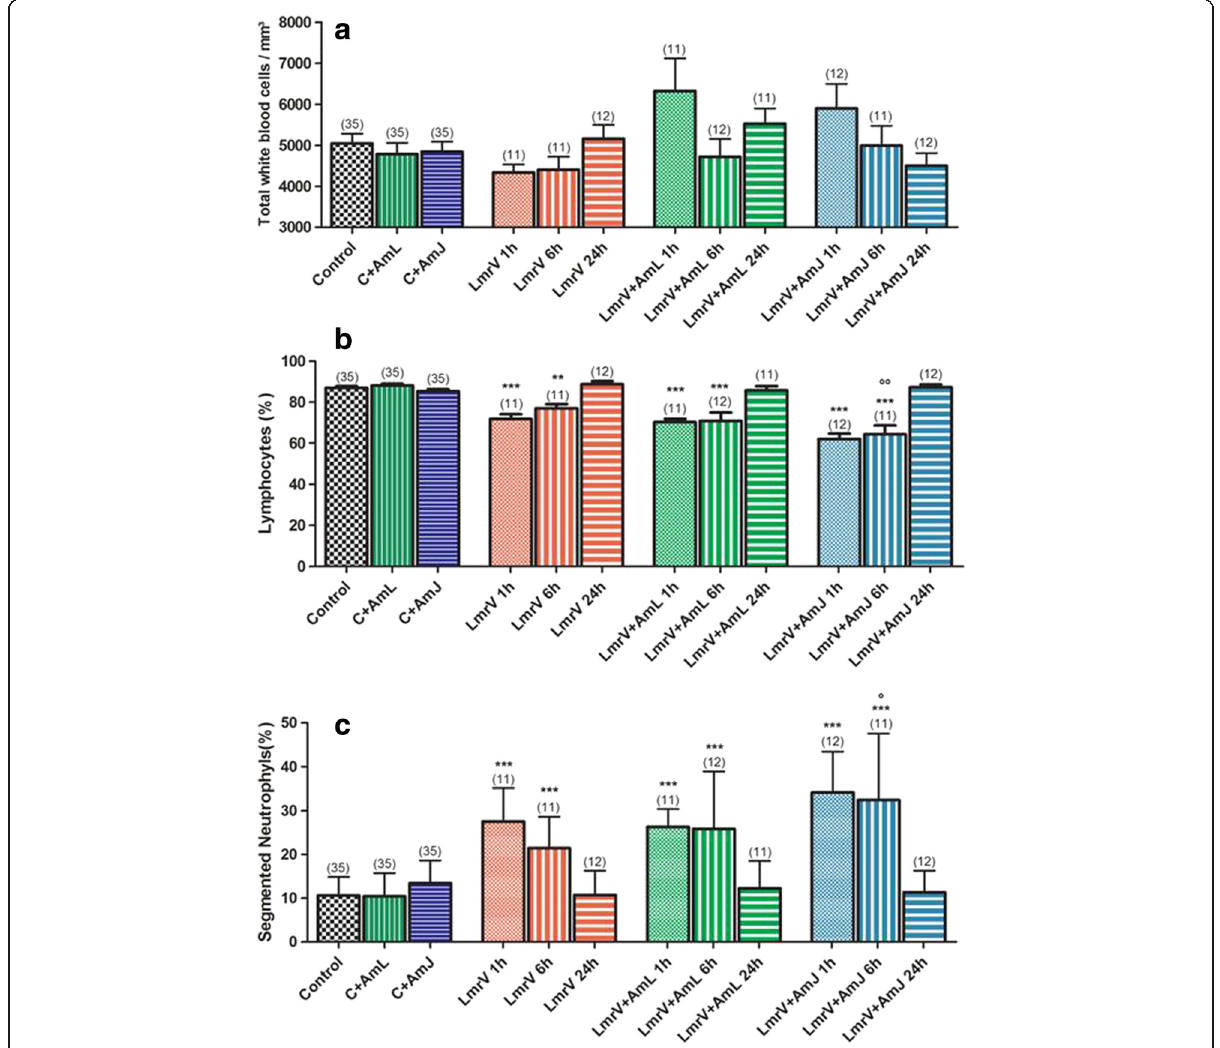
Fig. 6 a Total white blood cells count, b relative count of lymphocytes and c segmented neutrophils of male Wistar rats injected with 3 mg of Lachesis muta rhombeata venom, at 1, 6 and 24 h after envenomation (LmrV) and with their respective treatments with aqueous extract of Annona muricata L. leaves (LmrV + AmL) or Annona muricata L. juice (LmrV + AmJ). The numbers above the columns represent the number of animals used in each test. *** p < 0.001, ** p < 0.01 compared to control group. °° p < 0.001, ° p < 0.001 compared to envenomation group without treatment